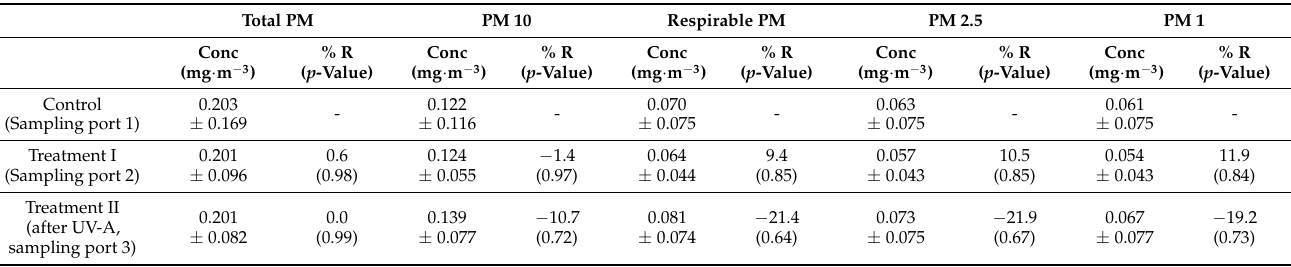
Table 3. Particulate matter removal performance of UV-A photocatalysis (Treatment II) in mitigating PM under no filtration condition (the ‘worst-case’